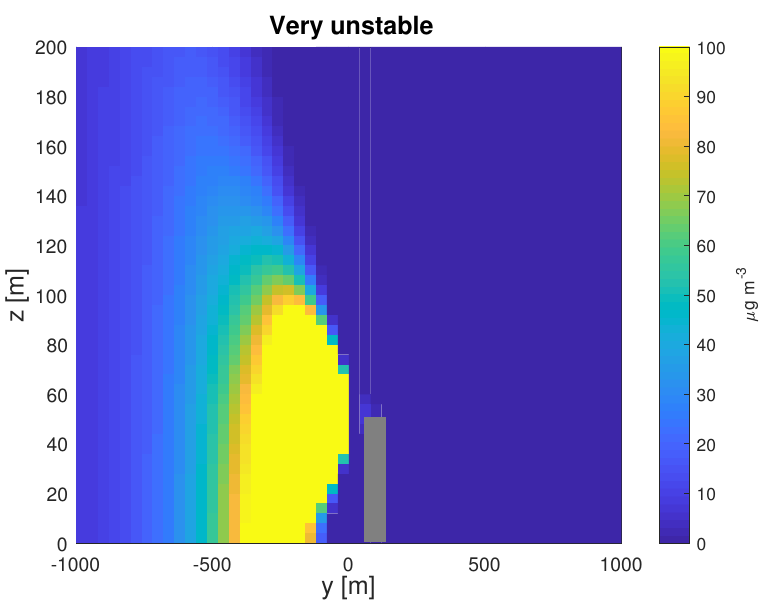
Figure 6. The 2D Gaussian pollutant concentration dispersion model in a plume for the very/extremely unstable situation. The gray bar represents the effective height of the emission point.